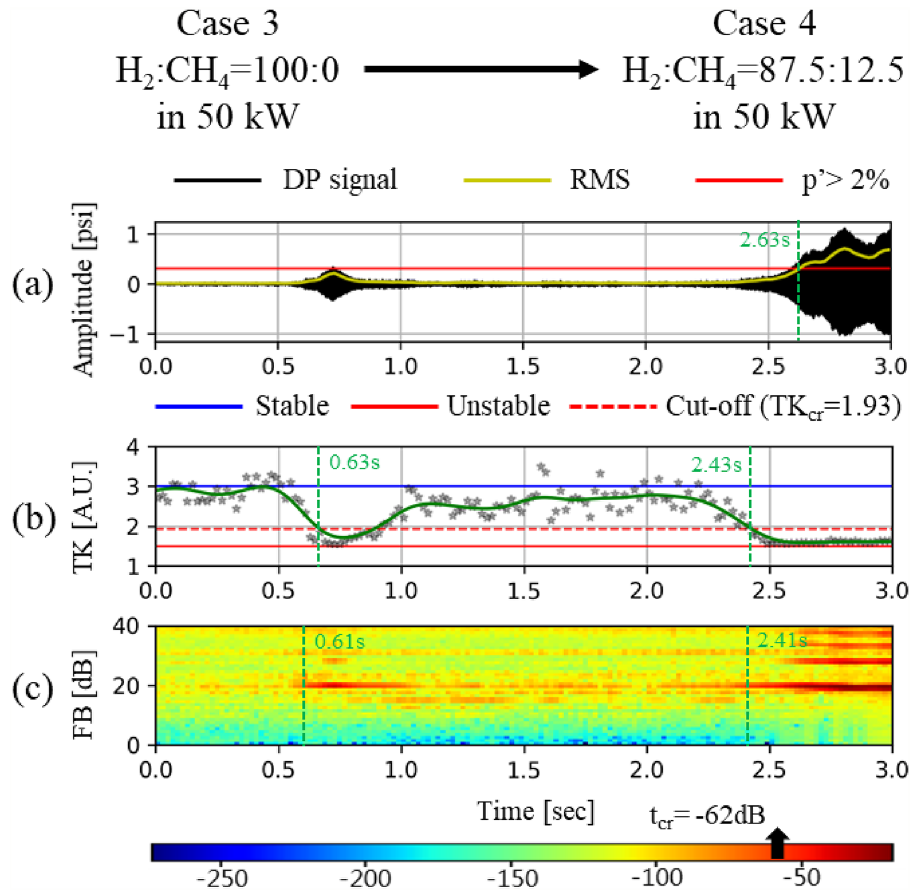
Figure 10. CI analysis results using ( a ) RMS, ( b ) TK, and ( c ) FB for transition from Case 3 to Case